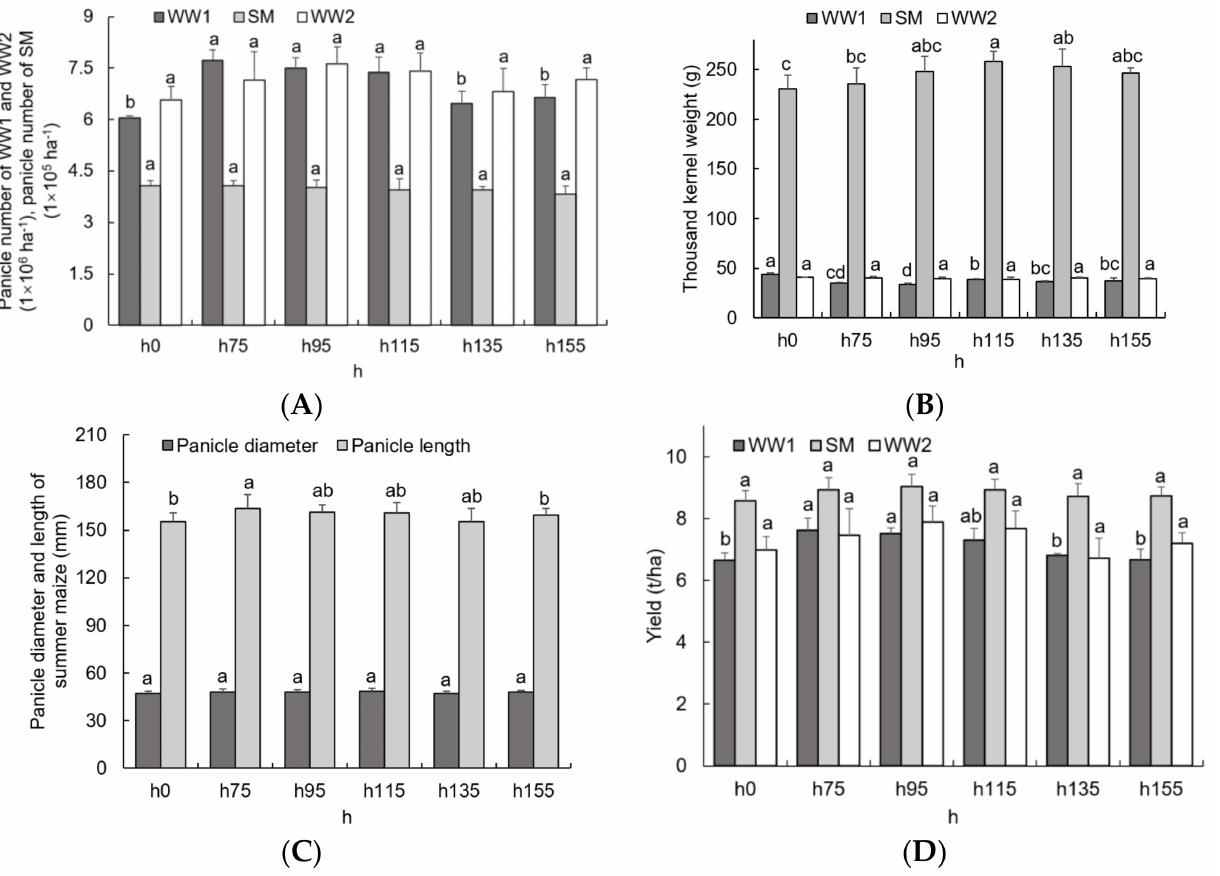
Figure 9. Panicle number ( A ), thousand kernel weight (TKW) ( B ), panicle diameter, and panicle length of summer maize (SM) ( C ), and grain yield ( D ). (WW1 and WW2 stand for winter wheat in the first growing season (2019–2020) and the second growing season (2020–2021), respectively; different letters (a–d) mean significant difference at p < 0.05; error bars represent standard deviations from the